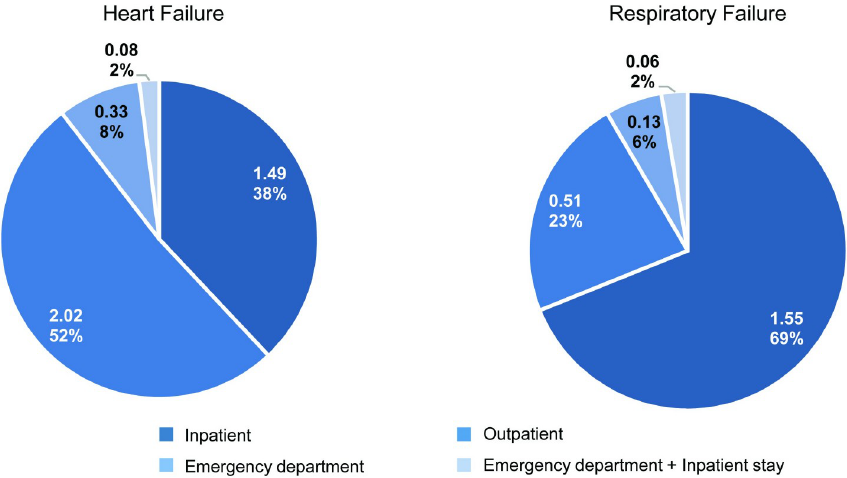
Fig 3. Heart failure- and respiratory failure-related healthcare utilization in the one-year post surgery. Healthcare utilization over the one-year period following index hospital discharge comprised an average number of the following visit types: Inpatient (1.49 HF; 1.55 RF), Outpatient (2.02, 0.51), Emergency Department (0.33, 0.13), Emergency Department + Inpatient (0.08, 0.06).